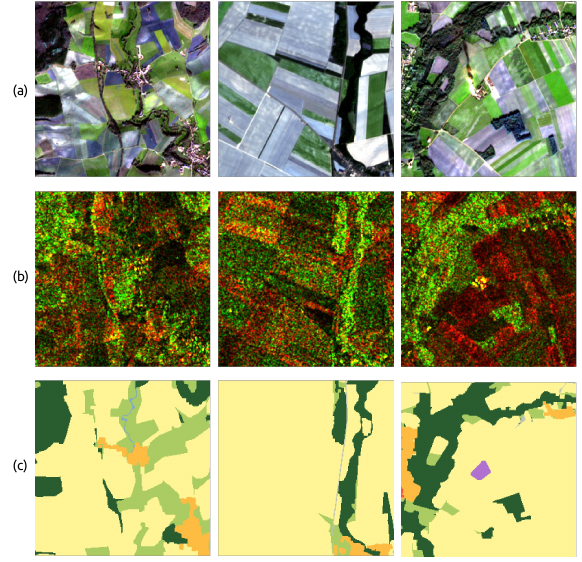
Figure 5. Triplets patches example with mono-temporal (a) Sentinel-2 in RGB, (b) SAR Sentinel-1 (Red : VV, Green : VH) and (c) the ground reference associated.